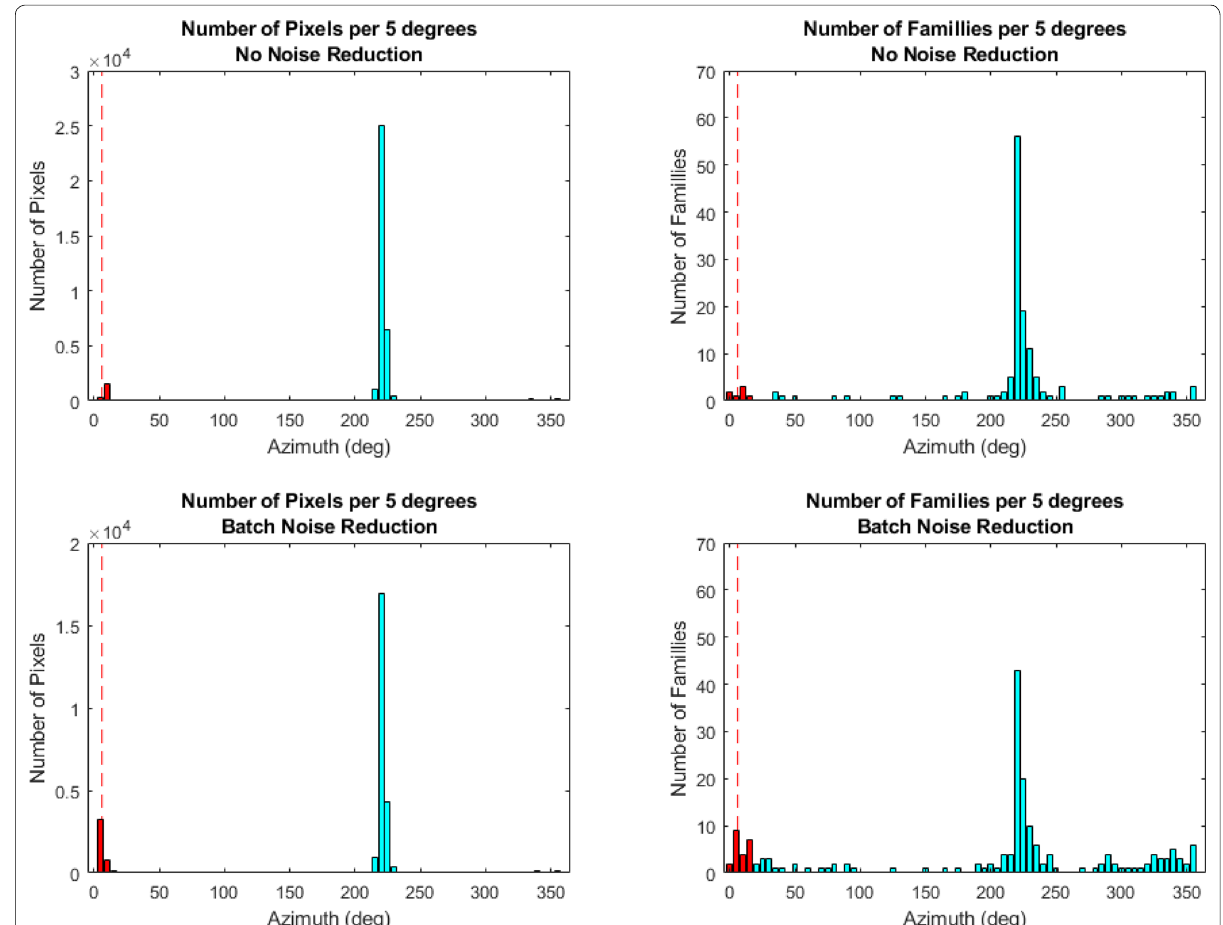
Fig. 7 Histograms of pixels and families per 5° bins from 0 to 360, for the station I04AU. The back azimuth for the volcano is 6° (dashed line). In the left column are the results for number of pixels within families per 5° bin for no noise reduction (top) and a batch noise reduction by station (bottom), the bins highlighted in red are around the known back azimuth (0°–10°). In the right column are the number of families for both no noise reduction (top) and batch noise reduction (bottom), again the bins around the known back azimuth are highlighted in